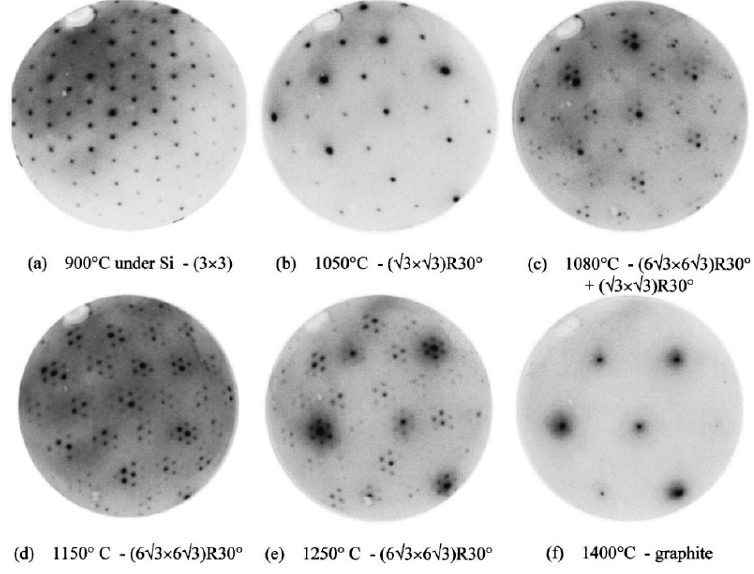
Figure 16. LEED patterns from 6H-SiC(0001) with a primary energy of 130 eV obtained on ( a ) (1 ˆ 1); ( b ) 3 ˆ 3 q R 30 ˝ ; ( c ) 3 ˆ 3 q R 30 ˝ + p 6 3 ˆ 6 3 q R 30 ˝ ; ( d , e ) p 6 3 ˆ 6 3 q R 30 ˝ ; and ( f ) graphite (1 ˆ 1) [41].